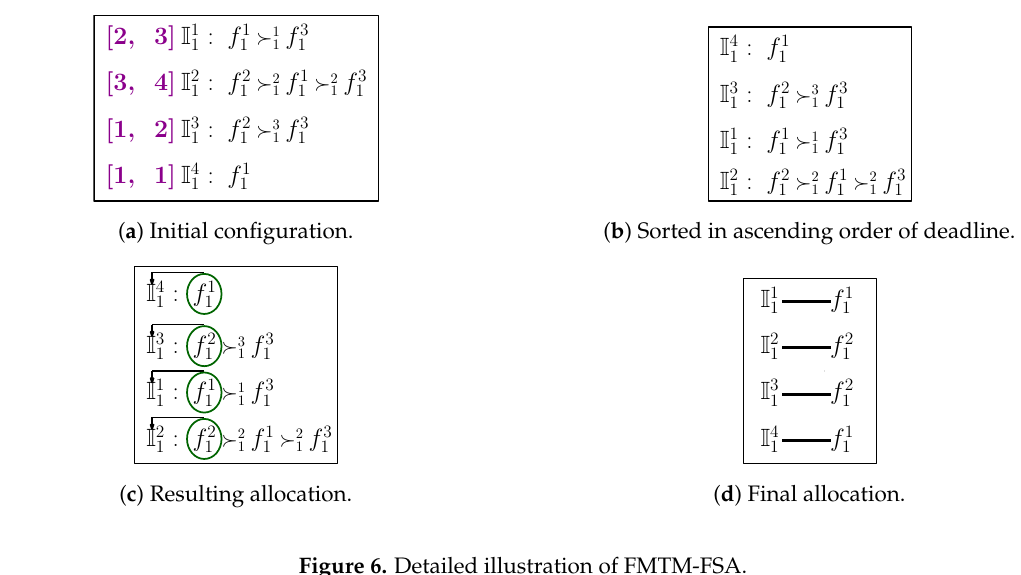
Figure 6. Detailed illustration of